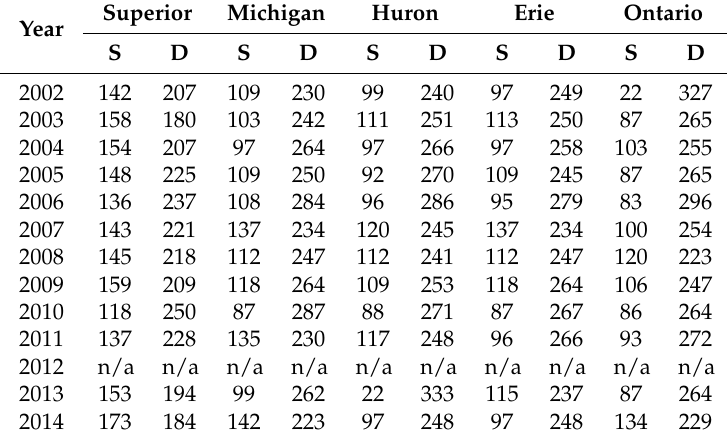
Table 3. Start date (day of year) and duration (day) of the lake-wide average stratification. Year